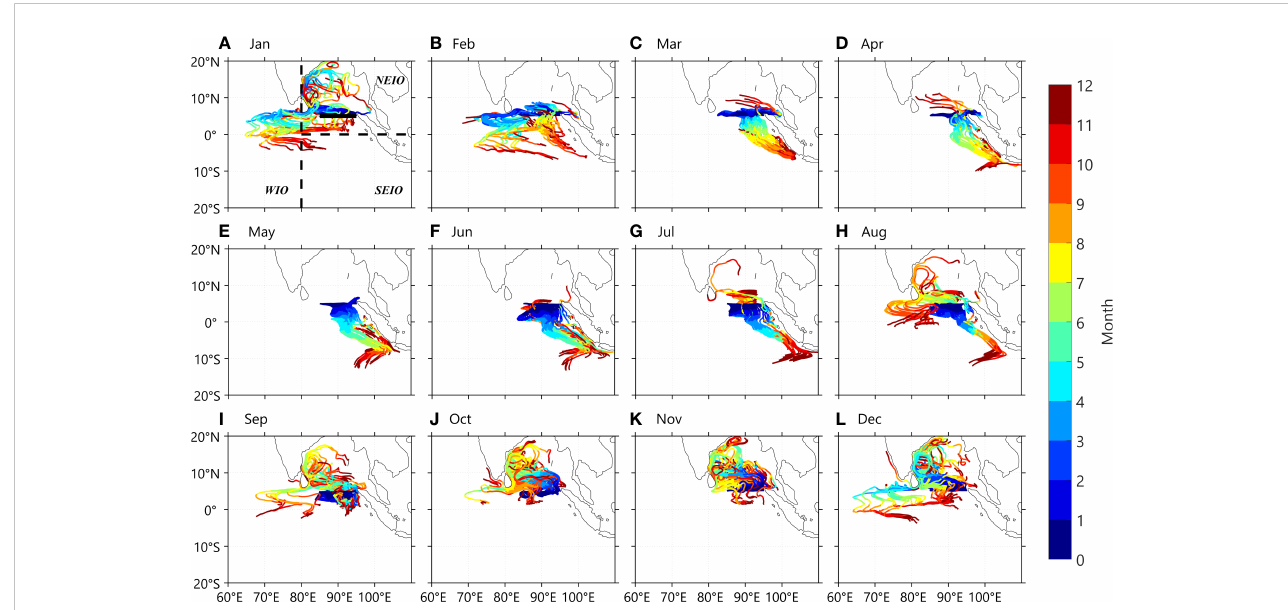
FIGURE 3 Trajectories of particles released on the 1st of each month and tracked forward in time for a year using the ECCO2 currents data. The solid black line in (A) represents the initial locations (85°E-95°E, 5°N) of the particles released with an interval of 0.02° in the zonal direction. For clarity, only 10% of the particle trajectories are shown. The black dotted lines in (A) mark the three regions: NEIO, northern part of the EIO; SEIO, southern part of the EIO; WIO, western Indian